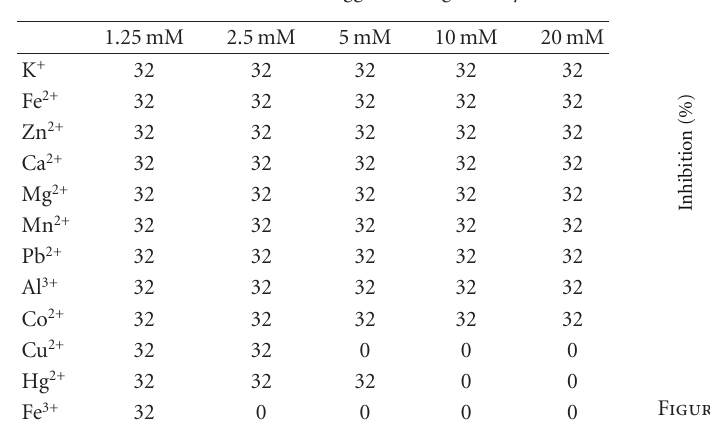
Table 5: E ff ects of cations on hemagglutinating activity of HEA.